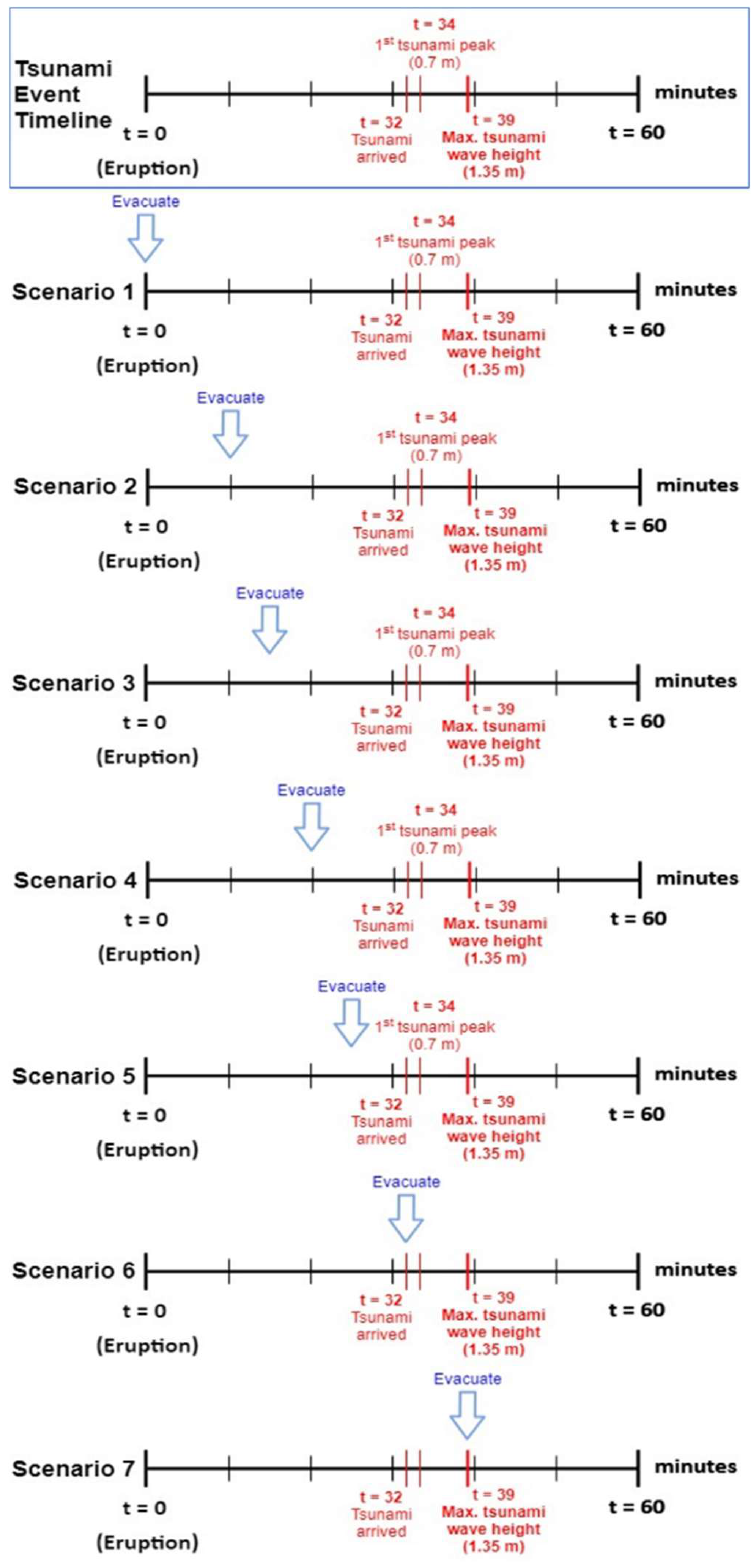
Figure 7. Tsunami event timeline and seven simulation scenarios with different delay times.